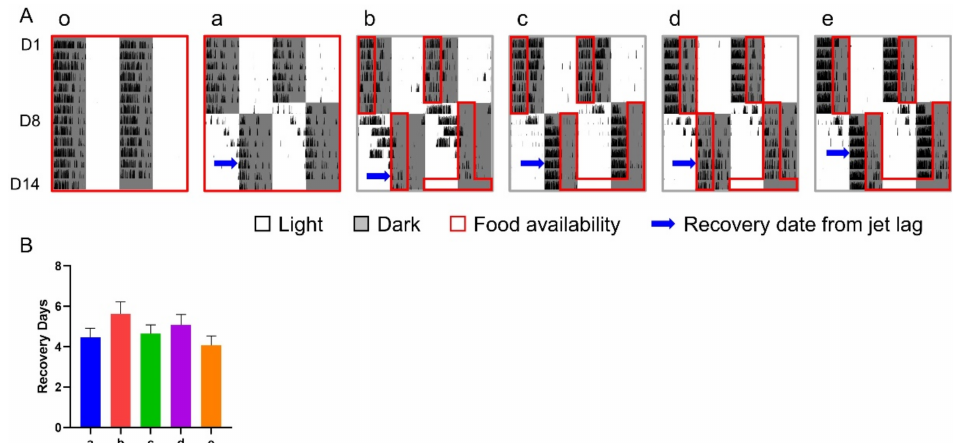
Figure 4. Effect of 6-h TRFs on behavioral adaptation in mice treated with a 12-h shift. ( A ), Repre- sentative double-plotted actograms of wheel running activity of mice in group o–e; ( B ), Days for recovery from the shift. None of the groups are statistically different from each other. One-way ANOVA with Tukey’s multiple comparisons test ( n = 8–14).